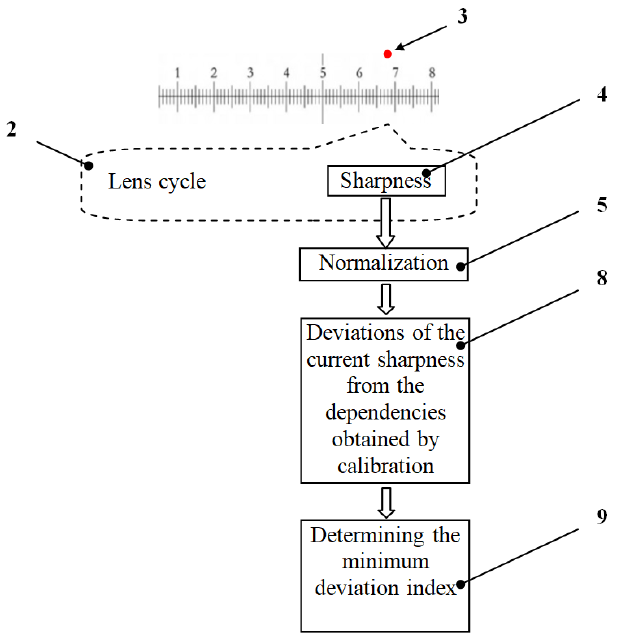
Figure 4. Block diagram of the measurement phase.